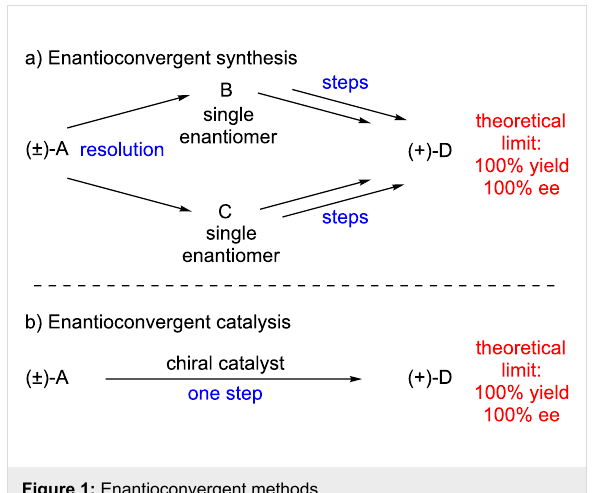
Figure 1: Enantioconvergent